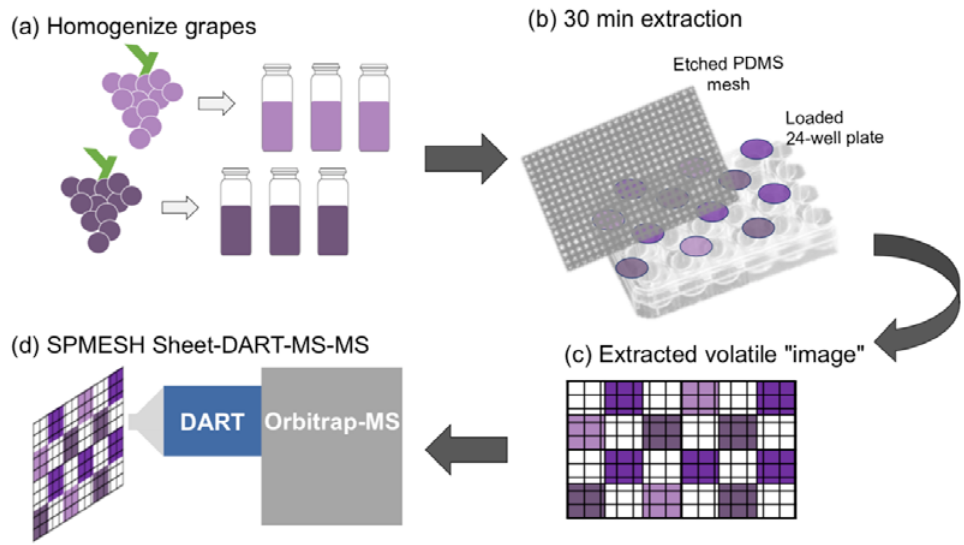
Figure 1. Schematic overview of sample preparation, SPMESH (solid phase mesh enhanced sorption from headspace) extraction and DART (Direct Analysis in Real Time)-Orbitrap-MS analysis.